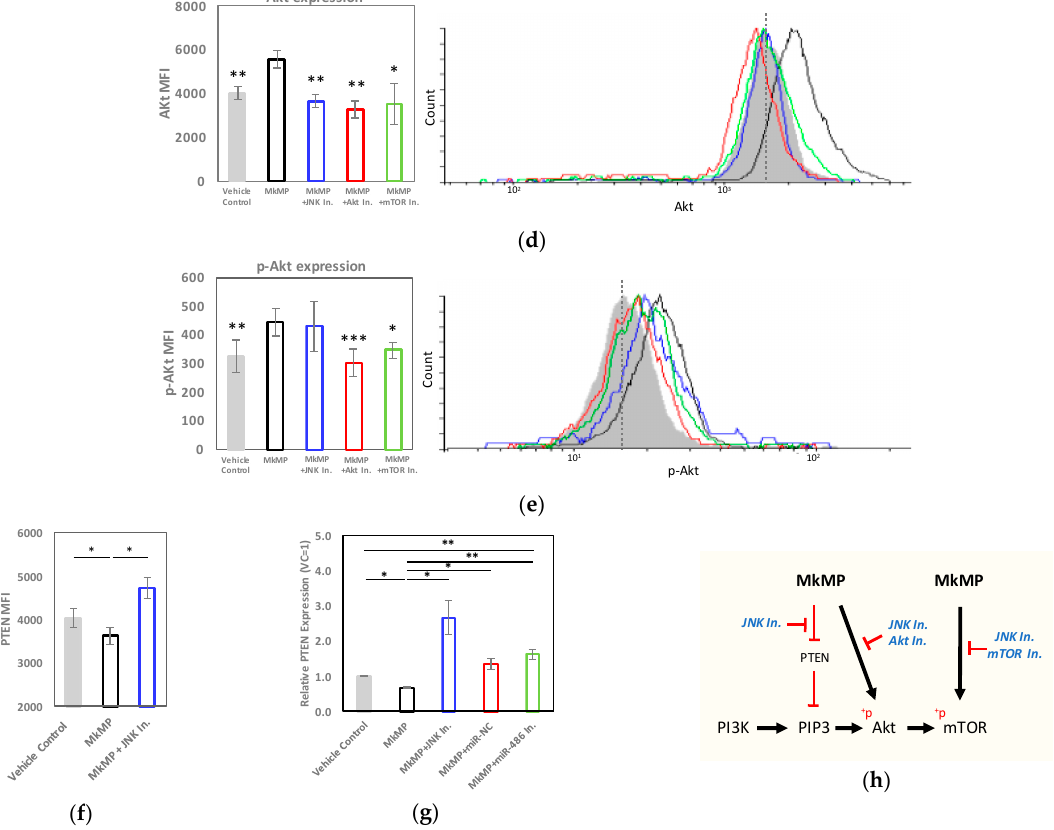
Figure 6. MkMPs activate PI3K/Akt/mTOR signaling in CD34 + HSPCs by targeting PTEN and me- diate JNK signaling. ( a , b ) CD34 + HSPCs were co-cultured with MkMPs or vehicle control. Cells were harvested after 24 h of co-culture, and the level of targets including mTOR, p-mTOR, and Akt were examined by immunoblotting with GAPDH as the loading control. ( a ) Representative immunoblot images out of 4 replicates. ( b ) Semi-quantification of p-mTOR expression from immunoblot images (n = 4). The expression levels for p-mTOR were normalized to the expression of GAPDH. ( c – e ) CD34 + HSPCs were pretreated with a signaling inhibitor (JNK, Akt, or mTOR inhibitor), or inhibitor vehicle (without an inhibitor), and were co-cultured with MkMPs or without (vehicle control). Cells were harvested after 24 h of co-culture, and the level of p-mTOR, Akt, and p-Akt were examined and quantified by flow cytometric analysis (n = 3–5). Mean fluorescence intensity (MFI) represents the protein expression/levels averaged over the total cell population. Representative histograms of each target are shown on the right. The Y -axis represents the event (cell) count for each specific fluores- cent intensity ( f , g ) CD34 + HSPCs pretreated with JNK inhibitor or solution without an inhibitor were co-cultured with MkMPs or vehicle control for 24 h. ( f ) PTEN protein expression was quantified by flow cytometric analysis, while ( g ) PTEN mRNA levels were quantified by qPCR analysis. ( h ) Sche- matic diagram of signaling pathway triggered by MkMPs in CD34 + HSPCs, based on the results from ( a – f ). Error bars in ( b ) represent the standard error of mean of 2–4 biological replicates, while error bars in ( c – g ) represent the standard error of mean of 3–5 biological replicates. Statistical com- parison analysis was performed between each experimental group against MkMP control (without inhibitor). * p < 0.05, ** p < 0.01, *** p < 0.001. Phosphatase and tensin homolog (PTEN) is a negative regulator of PI3K/Akt signal- ing in HSC development [36,37]. A loss of PTEN results in enhanced cellular proliferation [38] and megakaryopoiesis [39] due to overactive PI3K/Akt signaling. We hypothesized that activation of PI3K/Akt/mTOR signaling by MkMPs might be PTEN mediated. We thus examined the mRNA level of PTEN by quantitative PCR, and the PTEN protein level